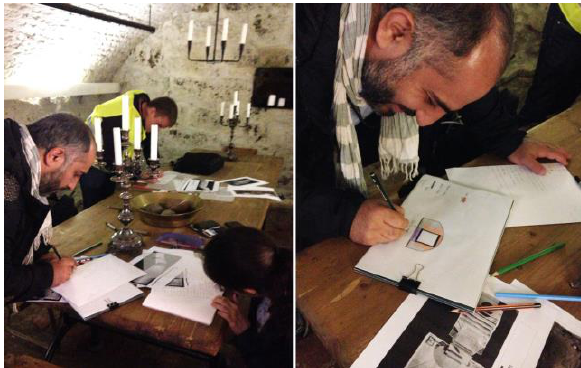
Figure 13. Student conducting stratigraphic analysis in